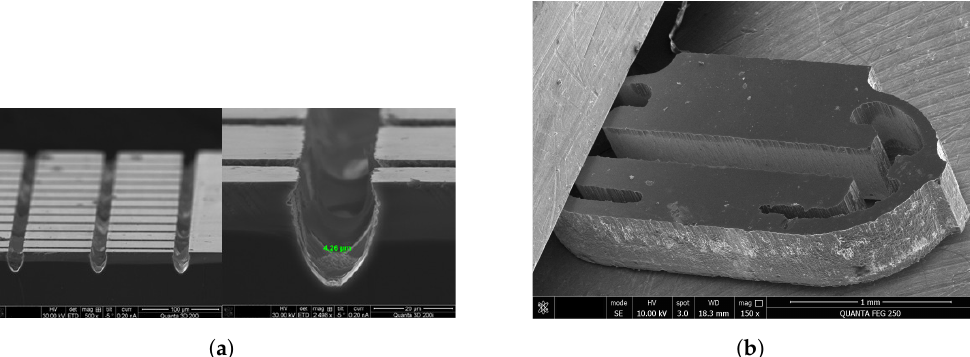
Figure 19. Experimental mechanical element of a transducer in a micrometer range (+ detail) ( a ). Experimental compliant mechanical element of a transducer in a millimeter range ( b